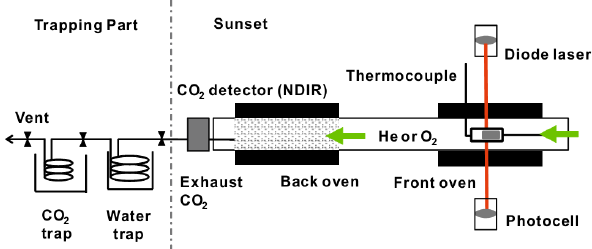
Fig. 1. Set-up of coupling the OC/EC analyser (Sunset) to the cryo- Fig. 1. genic traps.